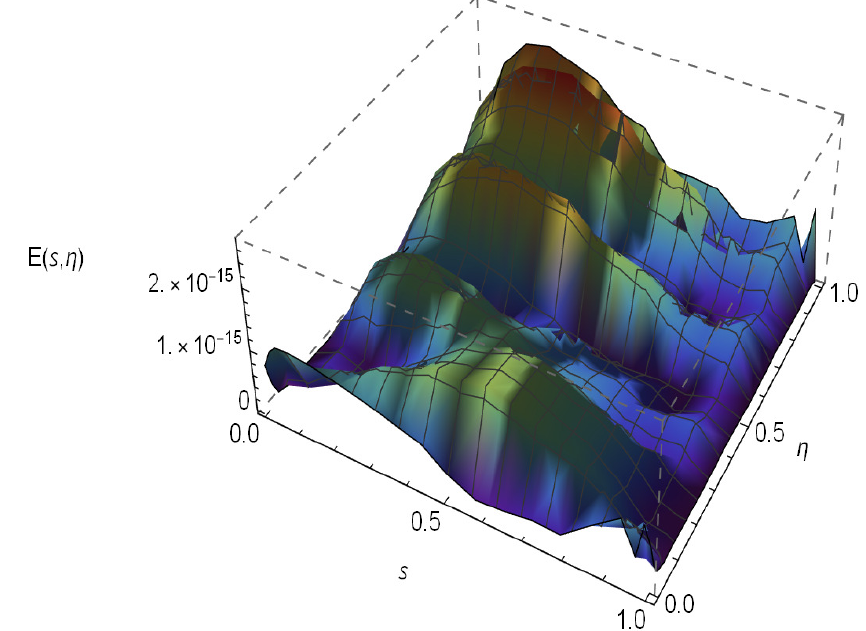
Figure 2. Absolute errors of problem (17), where ε = 1.7, ν = 0.9, N = M = 10.